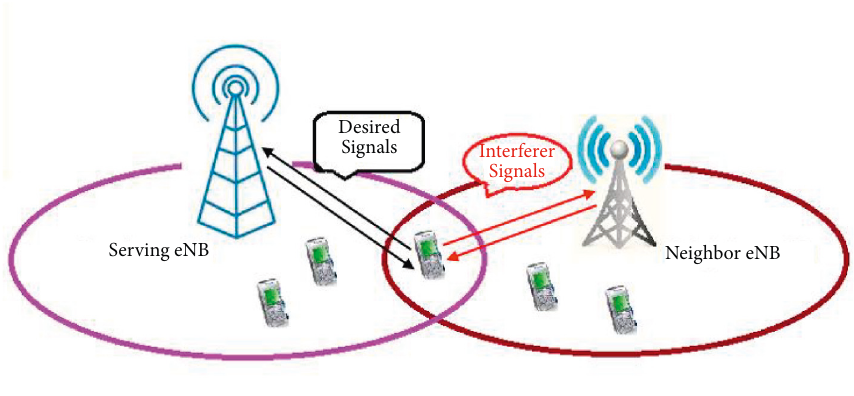
Figure 2: Intracell interference at the cell edges.